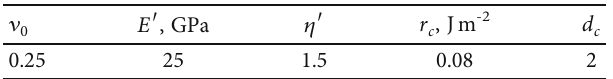
Table 4: The parameters of [48].